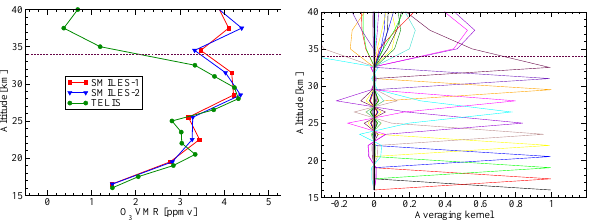
Fig. 24. Same as in Fig. 23, but for the SMILES Band-B compar- Fig.24. SameasinFig. 23,butfortheSMILESBand-Bcomparisons. high as 90 km, the secondary mesospheric O 3 maximum Odin/SMR,andAura/MLSforvariouslocaltimes,andwith is clearly shown. At 0.001 hPa, the peak maximum of O 3 TELISballoonobservations. reached to 6.5 ppmv between 1–4 am. At 0.01 hPa the sys- Error analysis : The results of the error analysis for tematic error is about 0.1 ppmv. The mesospheric diurnal 1235 SMILESv2.1.5showedthatthealtitudesensitivityofthesin- 1260 variationof O 3 isdetectedwithintheerorrsignificantly. gle scan measurementranges from ∼ 16 to ∼ 90km ( ∼ 100– 0.001hPa) with a vertical resolution of 3–10km. The re- trieval error due to the measurement noise is very low, smaller than 1% of the retrieved O 3 VMRs, at ∼ 20–50km (40–1hPa). The systematic error is estimated to be about 1265 Weperformedobservationsofthediurnalvariationofozone 3–8%in the stratosphereand increases to 10% in the meso- ( O 3 ) in the height region of 250–0.0005 hPa using the Su- sphere. Inthemesospherethespectralnoisebecomesamore perconductingSubmillimeter-WaveLimb-EmissionSounder 1240 dominanterrorsourcethanthemodelparameters,whichim- (SMILES) on the Japanese Experiment Module (JEM) on pliesthataveragingoftheprofilesisrequiredtohaveabetter the International Space Station (ISS) between 12 October signal-to-noise-ratio. 1270 2009 and 21 April 2010. SMILES performed the O 3 spec- SMILES internal comparisons : The comparison of the tral observations at 625.371 GHz with one order of magni- differentinstrumentalsetupsforthe625.371GHz O 3 obser- tude better signal-to-noise ratios than past space-based mi- 1245 vation was performed. It was clearly shown that SMILES crowave instruments due to the use of new 4 K heterodyne O 3 has different performance in the Band-A and Band-B. receiver technology. The SMILES O 3 product (NICT L2 The reason is that there is a calibration non-linearity prob- 1275 version2.1.5)processedfromtheBand-AandBand-Bmea- lem left in the L1b spectrum. This affects especially lower surementsusedthecalibratedspectra,L1bversion007. stratospheric O 3 . We assessed the SMILES O 3 product version 2.1.5 1250 by error analysis, internal spectrum comparisons between This problem was fixed in the L1b version 008, which three different instrumental setups for the O 3 625.371 GHz is provided at the end of December 2012. The consistency transition, comparison between the two different algo- checkbetweenthetwodifferentretrievalprocessingsshowed 1280 rithms for the same SMILES O 3 observation, and com- a better agreement for the O 3 profile from Band-B. The in- parison with ozonesondes, with other satellite observations 1255 consistency between Band-A and -B O 3 is at the maximum by ENVISAT/MIPAS, SCISAT/ACE-FTS, Odin/OSIRIS, 10 % (at 8.3 hPa) in the equator conditions for December